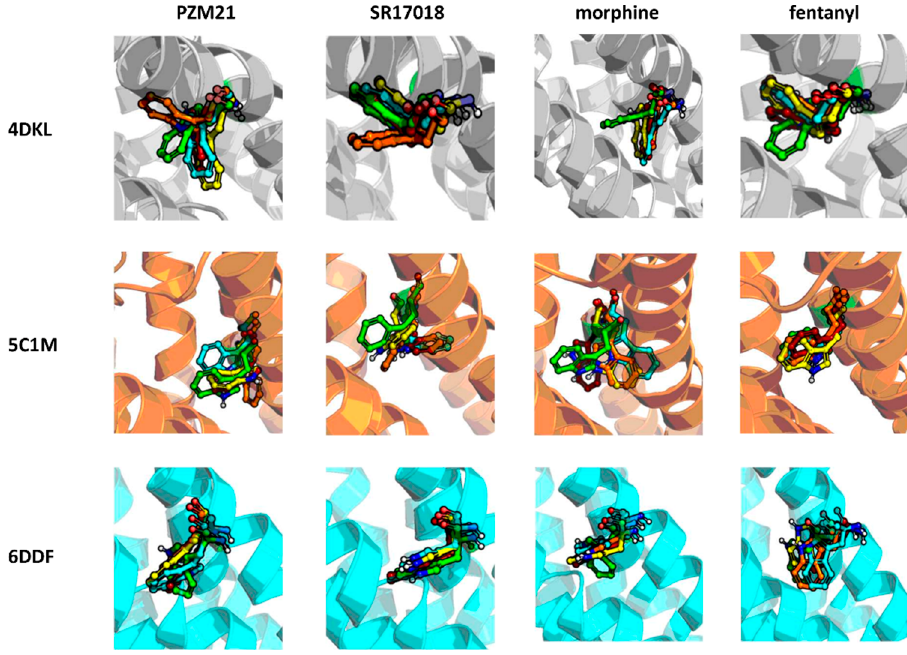
Figure 9. Position of W2936x48 during simulations with various ligands—green: starting pose; cyan: 250th frame; orange: 500th frame; yellow: 750th frame; red: 1000th frame.